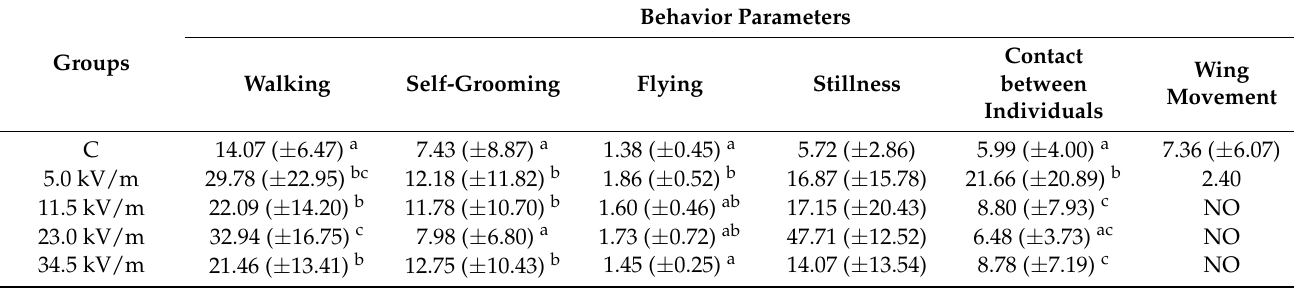
Table 3. Comparison of the average time spent on each behavior between the groups